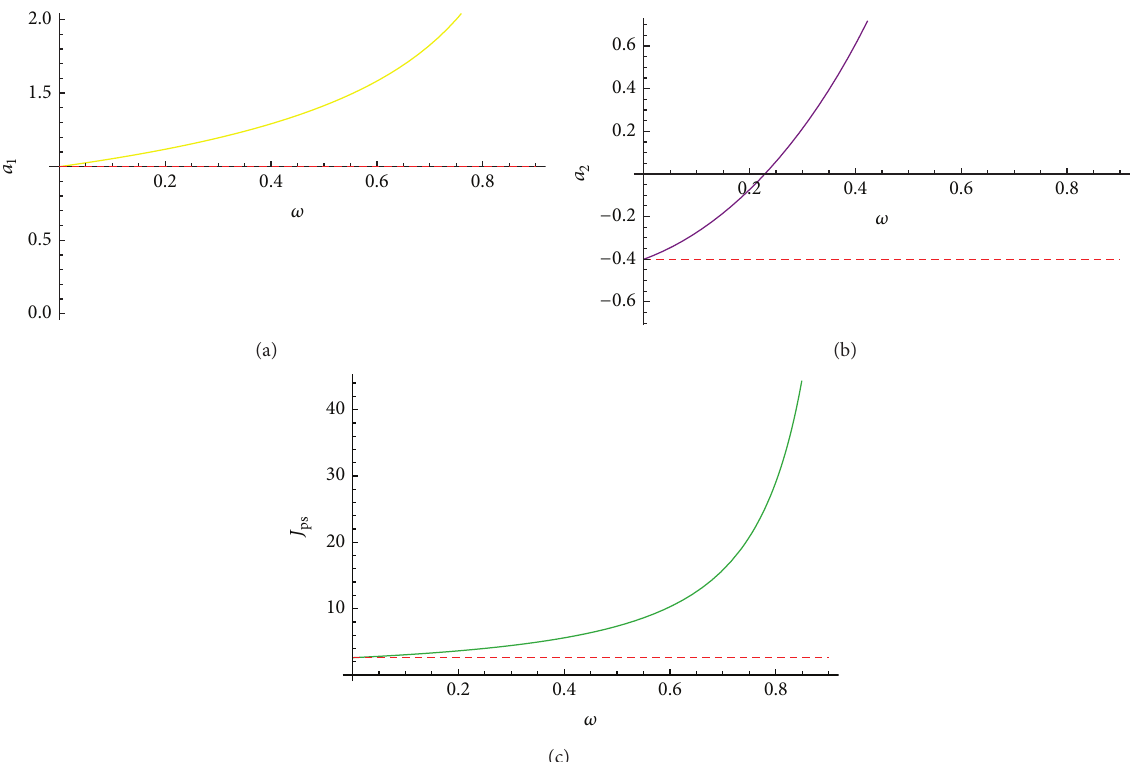
(c) as functions of 𝜔 are represented by yellow, ps